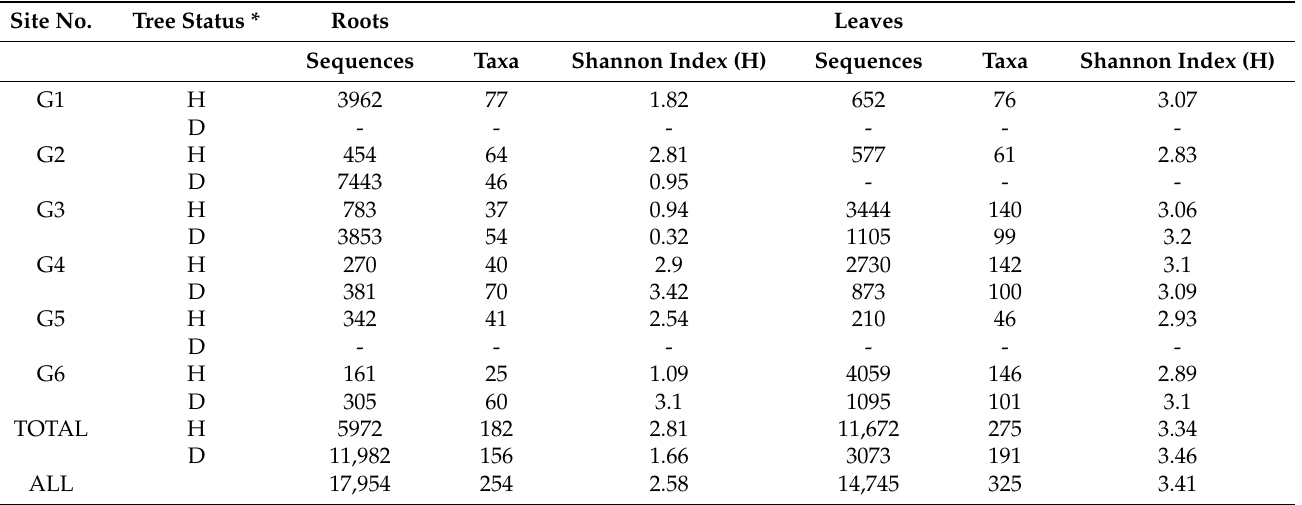
Table 2. Generated high-quality fungal sequences and detected a diversity of fungal taxa in different substrates from six Ulmus glabra sampling sites in